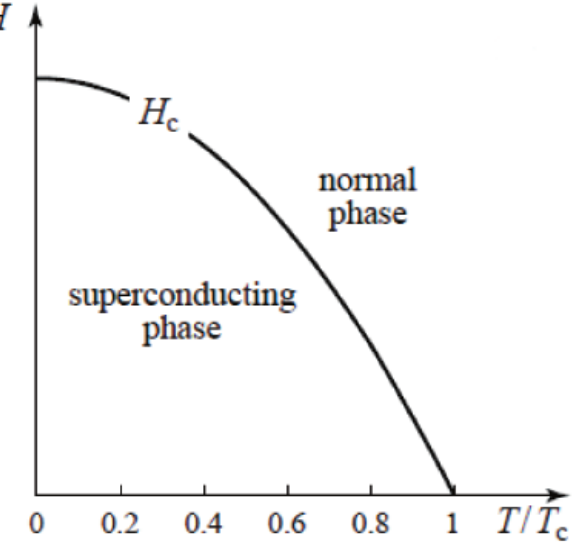
Figure 1. Temperature dependence of the critical magnetic field H c ( T )